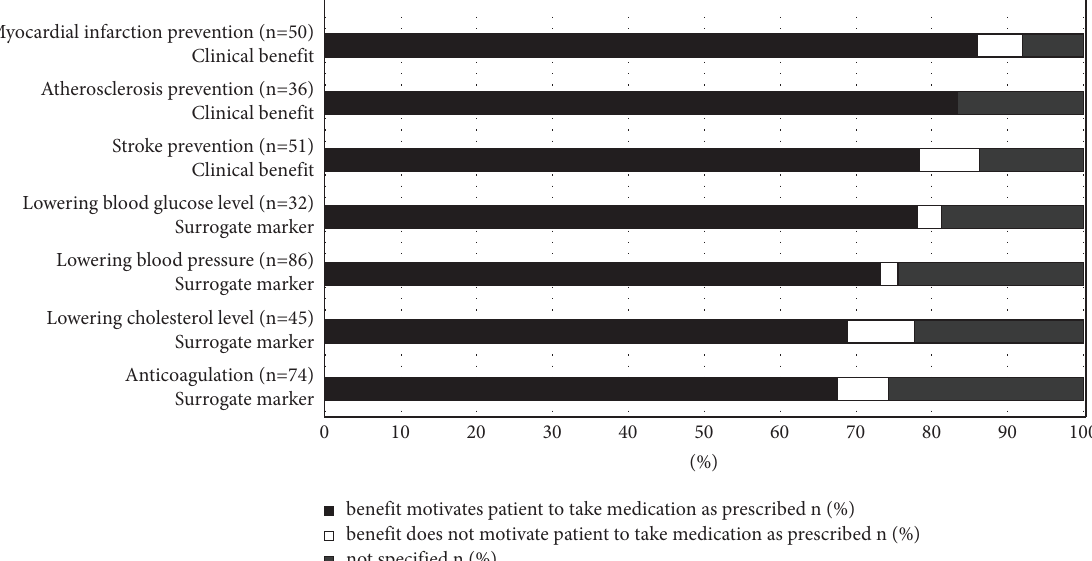
Figure 3: Motivation of associated benefts to take medication as prescribed. n (total) refers to the respective patients who mentioned the corresponding beneft. Surrogate markers and clinical benefts did not difer signifcantly in their patients’ motivation for adherence ( p � 0 .